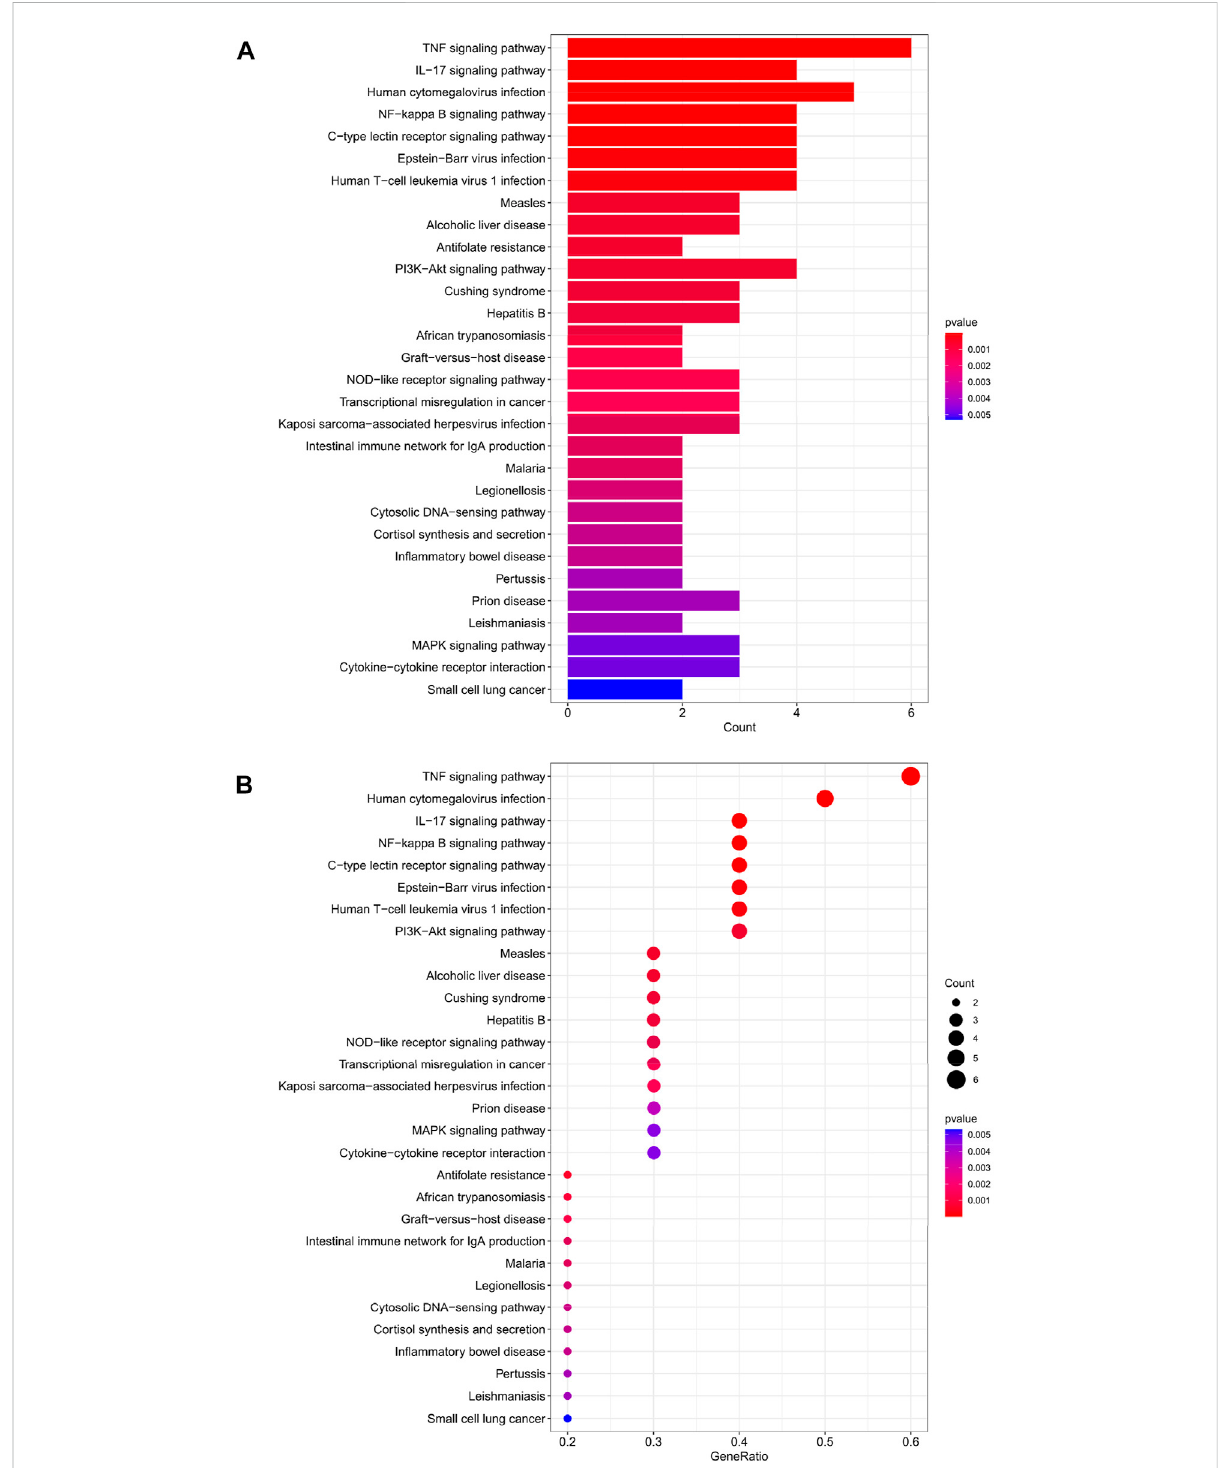
FIGURE 4 (A) Barchart plotted againsttheresults ofKEGG analysis for the11genesinTable 1, (B) Bubble chart plotted against theresults ofKEGG analysis for the 11 genes in Table